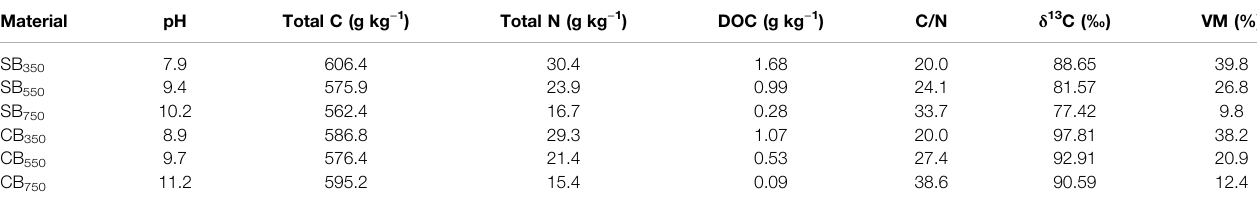
TABLE 1 | Properties of wood-derived biochar at three pyrolysis temperatures.